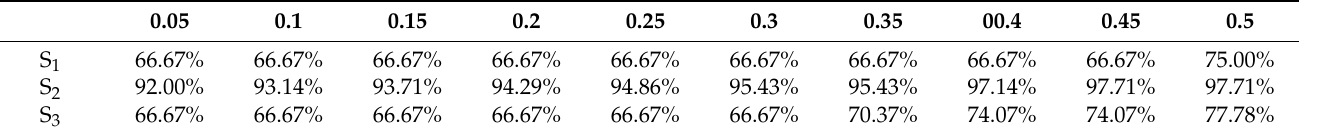
Table 8. th_score on